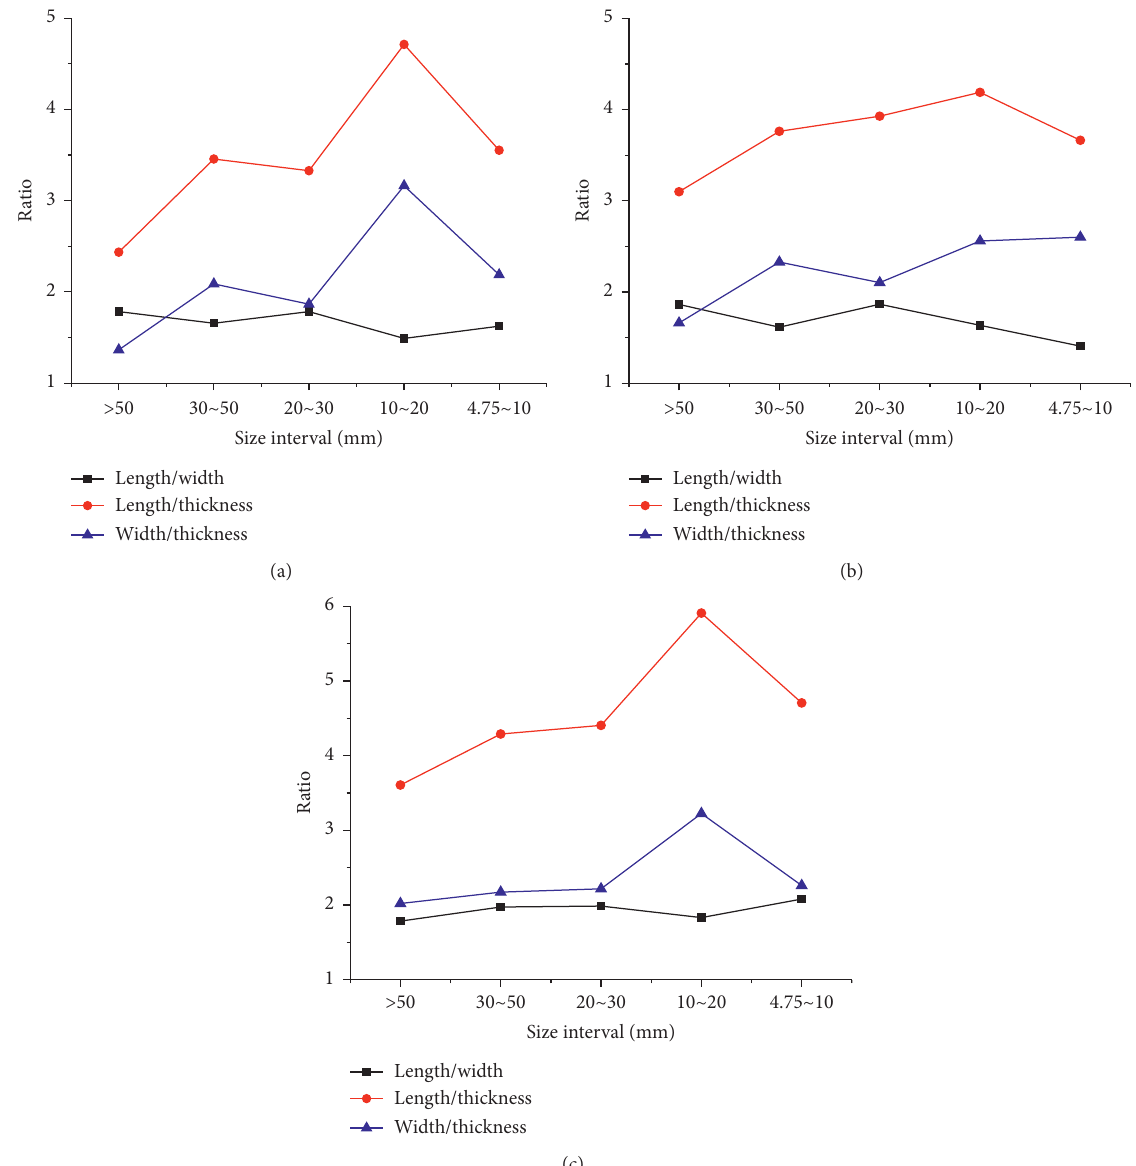
Figure 10: Size characteristics of limestone specimen fragments obtained under the uniaxial stress state. (a) Conventional compression test. (b) Cyclic loading test with a frequency of 0.25Hz. (c) Cyclic loading test with a frequency of 0.5